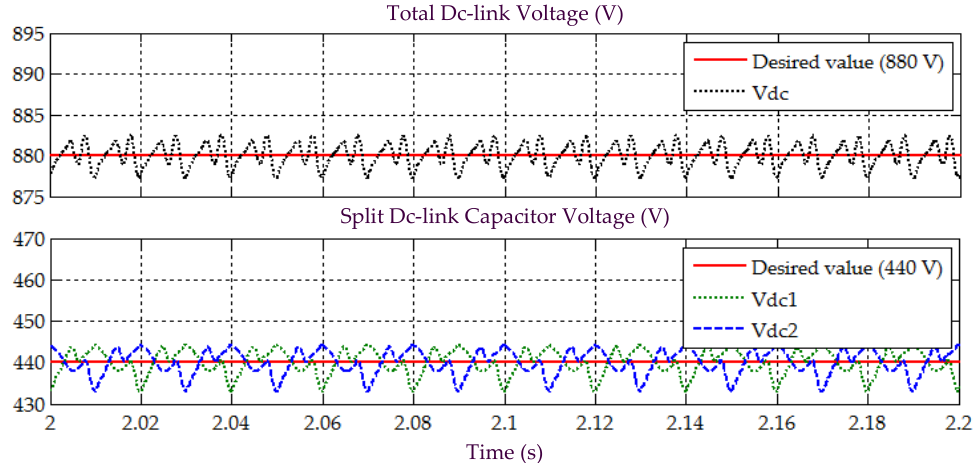
Figure 7. Simulation result obtained under Scenario A for Load 1, showing the total dc-link voltage 𝑉 𝑑𝑐 , and voltages across split dc-link capacitors 𝑉 𝑑𝑐1 and 𝑉 𝑑𝑐2 , demonstrated by SAPF while applying the proposed STF- dq 0 technique.